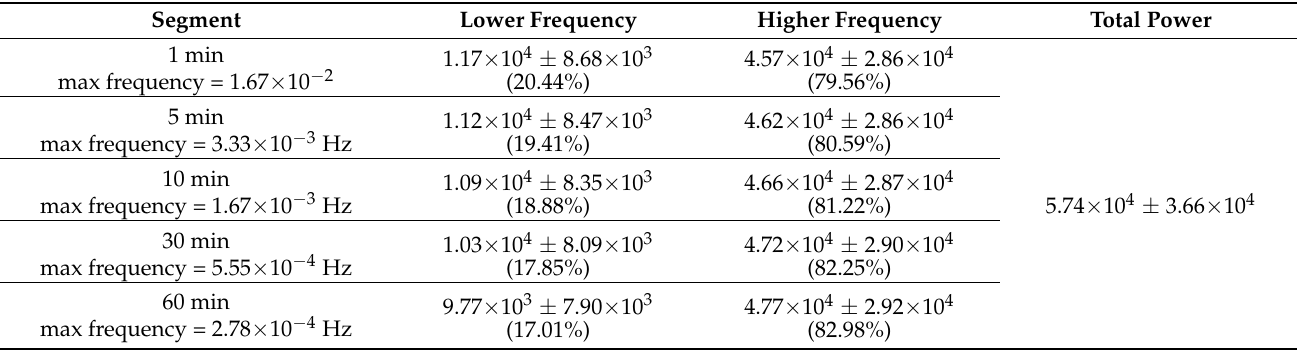
Table 3. Descriptive of power spectrum analysis expressed in ms 2 in all the segments length. In this table, the power of frequencies that are lower and higher than the maximal frequency that can be evaluated because of the segment length are reported. The results are reported as the mean ± standard deviation.